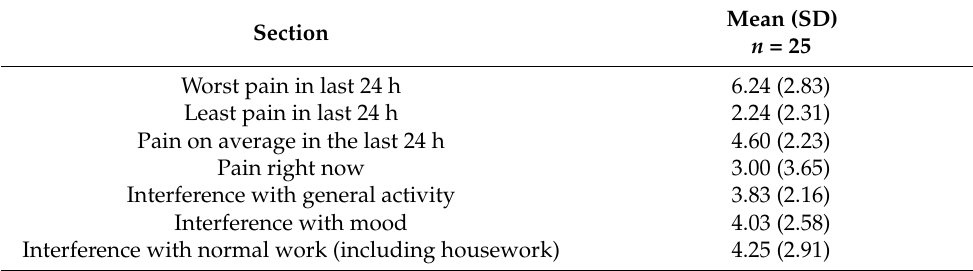
Table 2. Brief Pain Inventory scores.